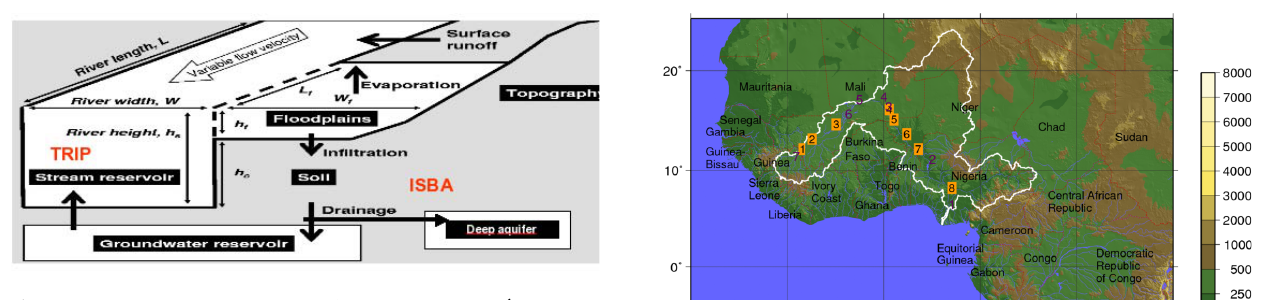
Fig. 1. Schematic representation of the ISBA/TRIP (Oki et al., 1999; Decharme, 2007) coupled system. The surface runoff calcu- lated by the land surface model (ISBA) flows into the stream reser- voir. The flood dynamic is described using a prognostic flood reser- voir which fills when the river height exceeds a critical value and vice versa. The flood fraction is based on sub-grid topography. Fi- nally, we add a linear aquifer reservoir so that the deep drainage is divided between the groundwater and the deep aquifer reservoirs.